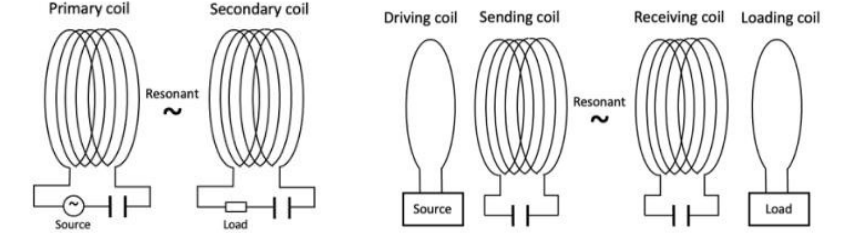
Figure 1. Typical models of two-coil ( left ) and four-coil ( right ) magnetically coupled resonant wireless power transfer (MR-WPT)